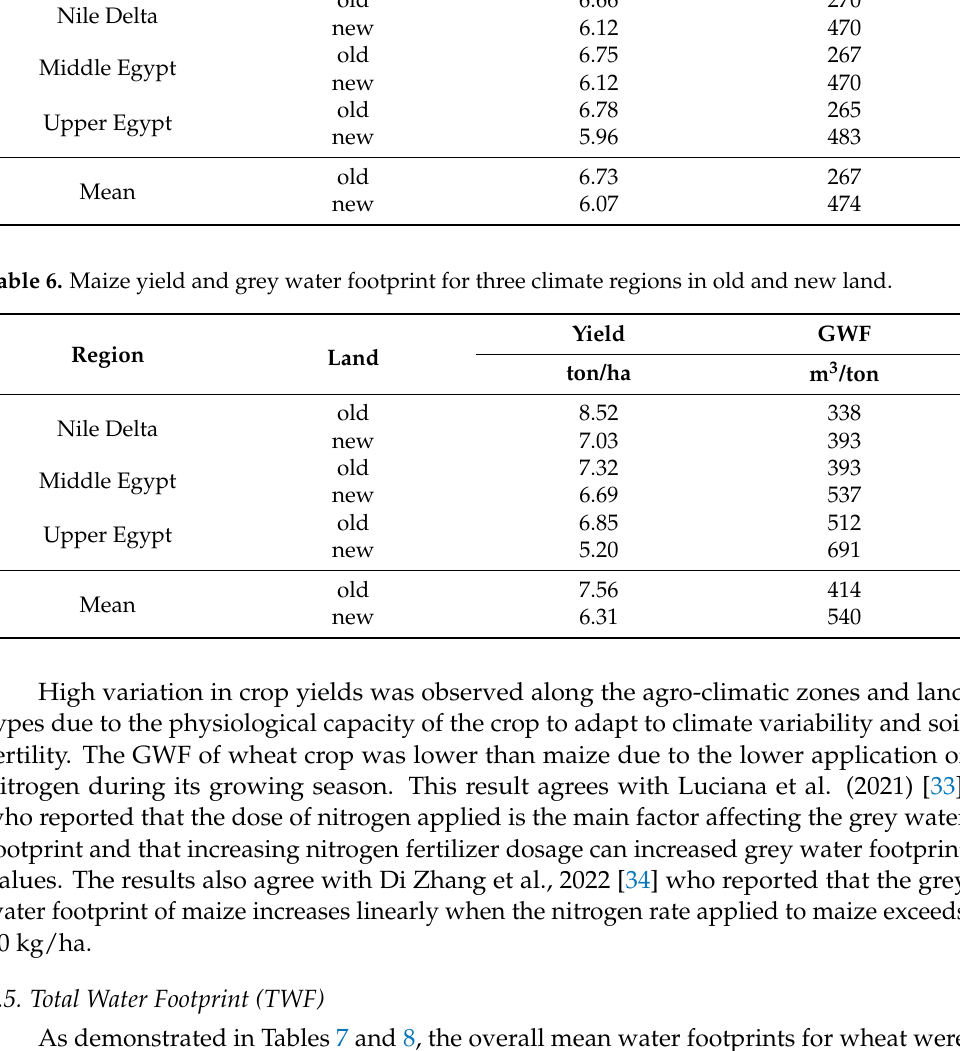
Table 5. Wheat yield and grey water footprint for three climate regions in old and new land. Yield GWF Region Land ton/ha m 3 /ton old Nile Delta